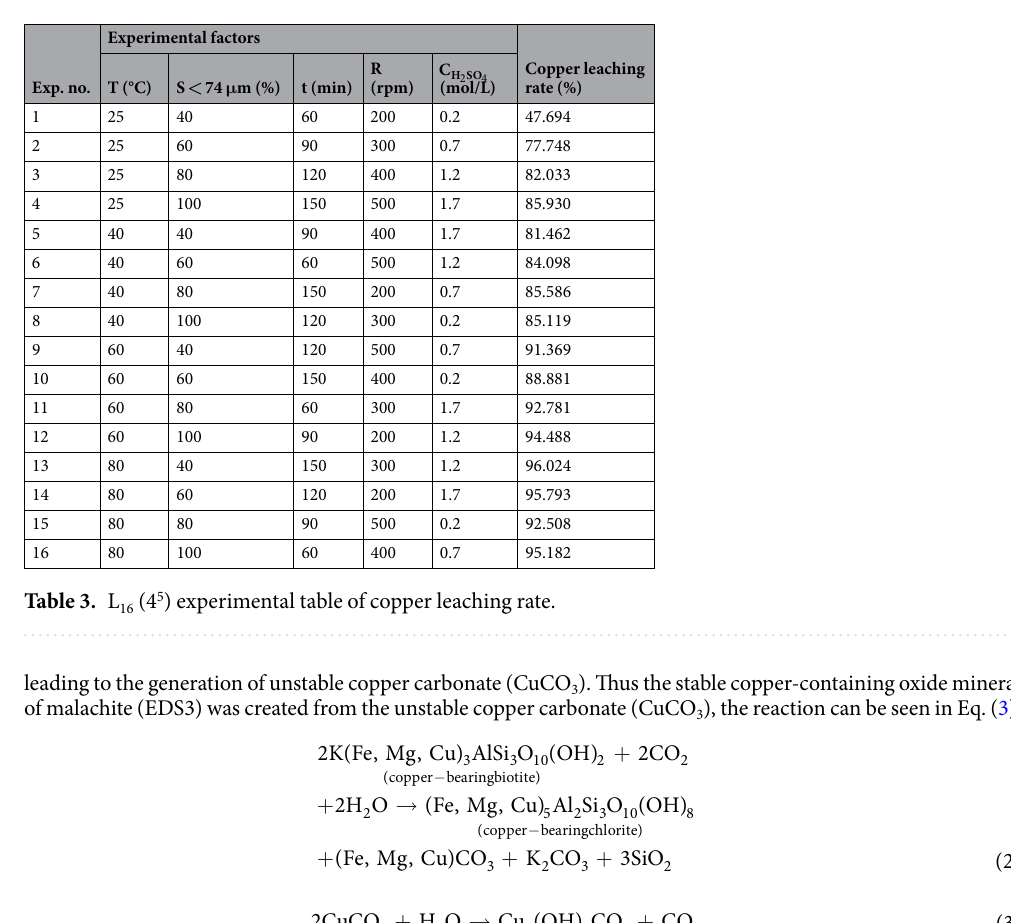
→ + The Δ rGm values for the Eqs (2) and (3) at 298.15 K are both less than zero, indicating that the processes of reactions (2) and (3) were spontaneous under natural conditions.